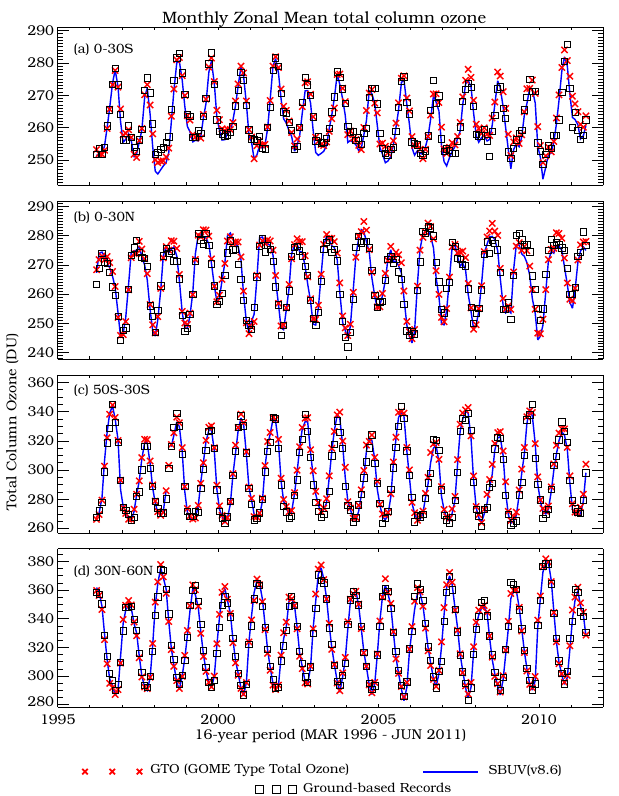
Figure 6. Differences in monthly mean zonal mean total